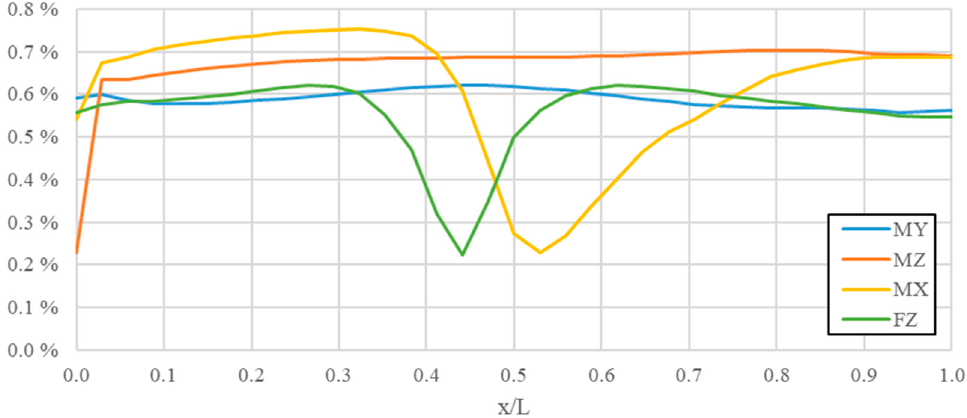
Figure 12. Elastic contribution on internal loads (MY, vertical bending moment; FZ, vertical shear force; MZ, horizontal bending moment; M X , torsional moment).